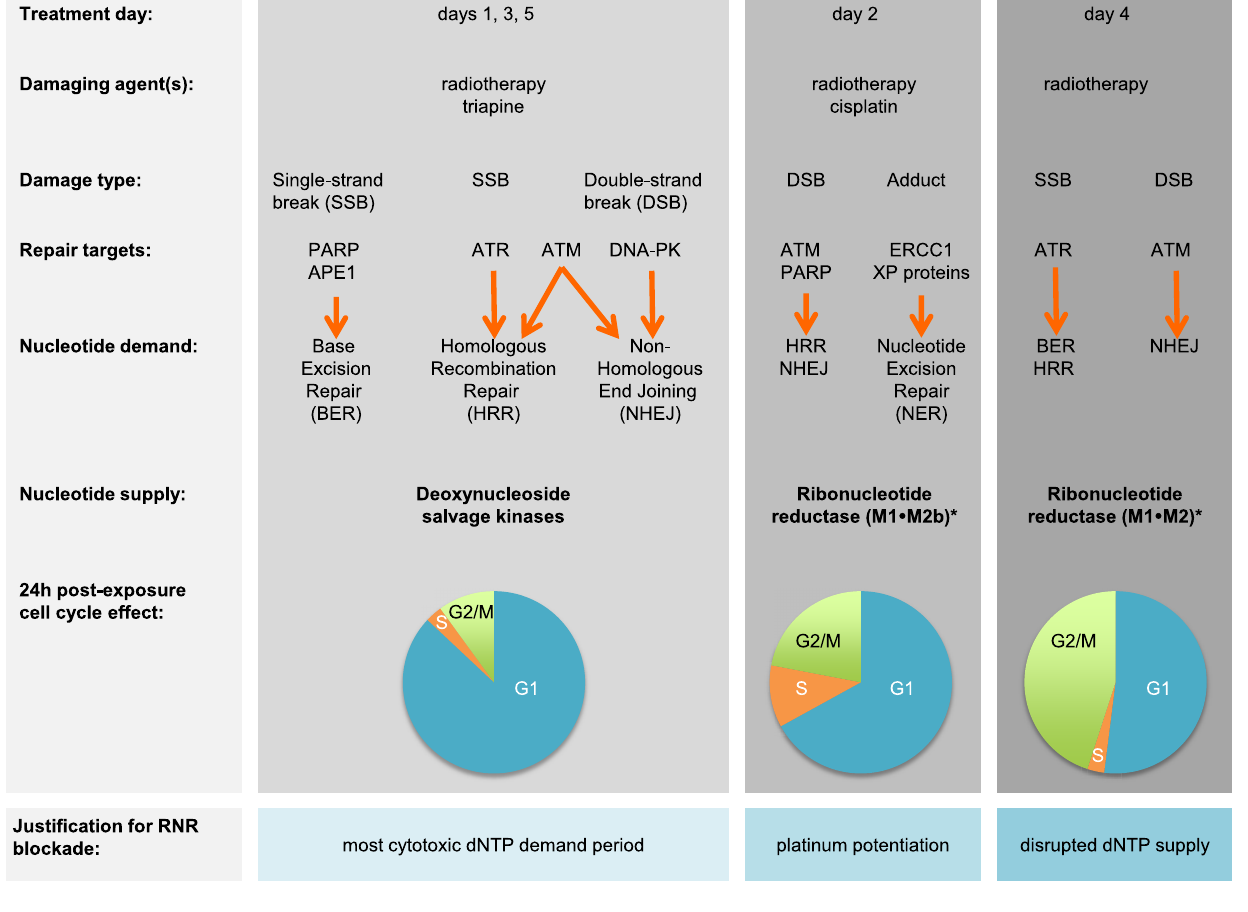
FigUre 1 | Triapine–cisplatin–radiation treatment and cell cycle targets. Damaging agents and DNA damage response repair targets are charted in relation to triapine–cisplatin–radiation treatment. Shown in bold are nucleotide supply chain elements likely to be active. *Data suggest M2 or M2b recycling after triapine exposure occurs over an 18-h period, but further validation is needed (21). Pie charts indicate representative 24-h cell cycle effects (22). Abbreviations: APE1, AP endonuclease 1; ATM, ataxia-telangiectasia mutated; ATR, ataxia-telangiectasia and Rad3-related; DNA-PK, DNA-dependent protein kinase; dNTP, deoxynucleotide triphosphate; ERCC1, DNA excision repair protein 1; PARP, poly(ADP-ribose) polymerase; RNR, ribonucleotide reductase; XP, xeroderma pigmentosum.